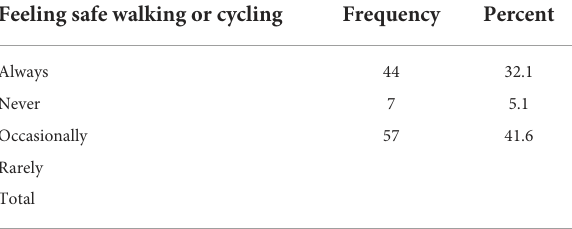
TABLE 7 Which of the following are you likely to engage to keep yourself safe when walking or cycling in the